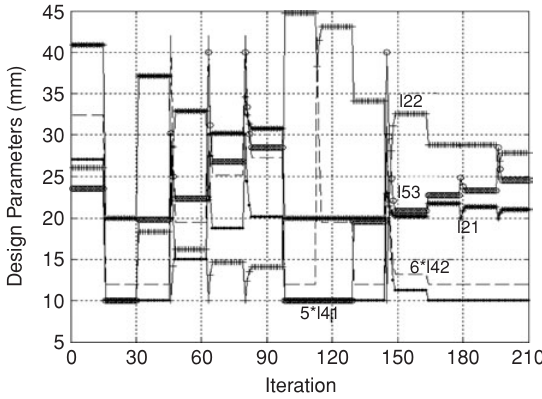
Figure 14 Evolution of design parameters l 22 , l 53 , l 21 , l 42 , l 41 .